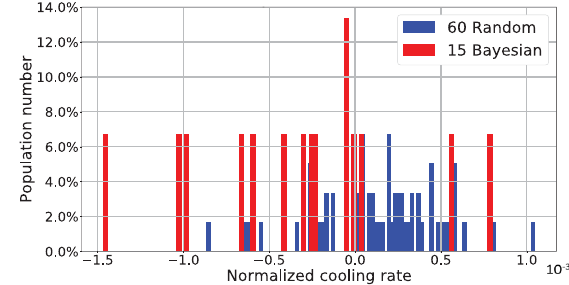
FIG. 5. The statistical distribution shows that the Bayesian samples (red) have a larger percentage of populations that possess a higher cooling rate compared with the random samples